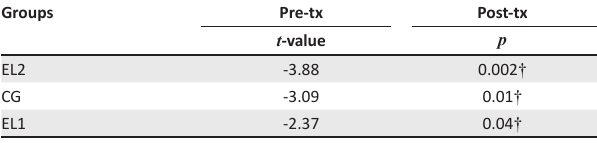
FIGURE 2: Average scaled scores on phonological segmentation across all groups. TABLE 3: Results of t -tests for significant differences in pre- and post-intervention scores on phonological segmentation scores within groups. Groups